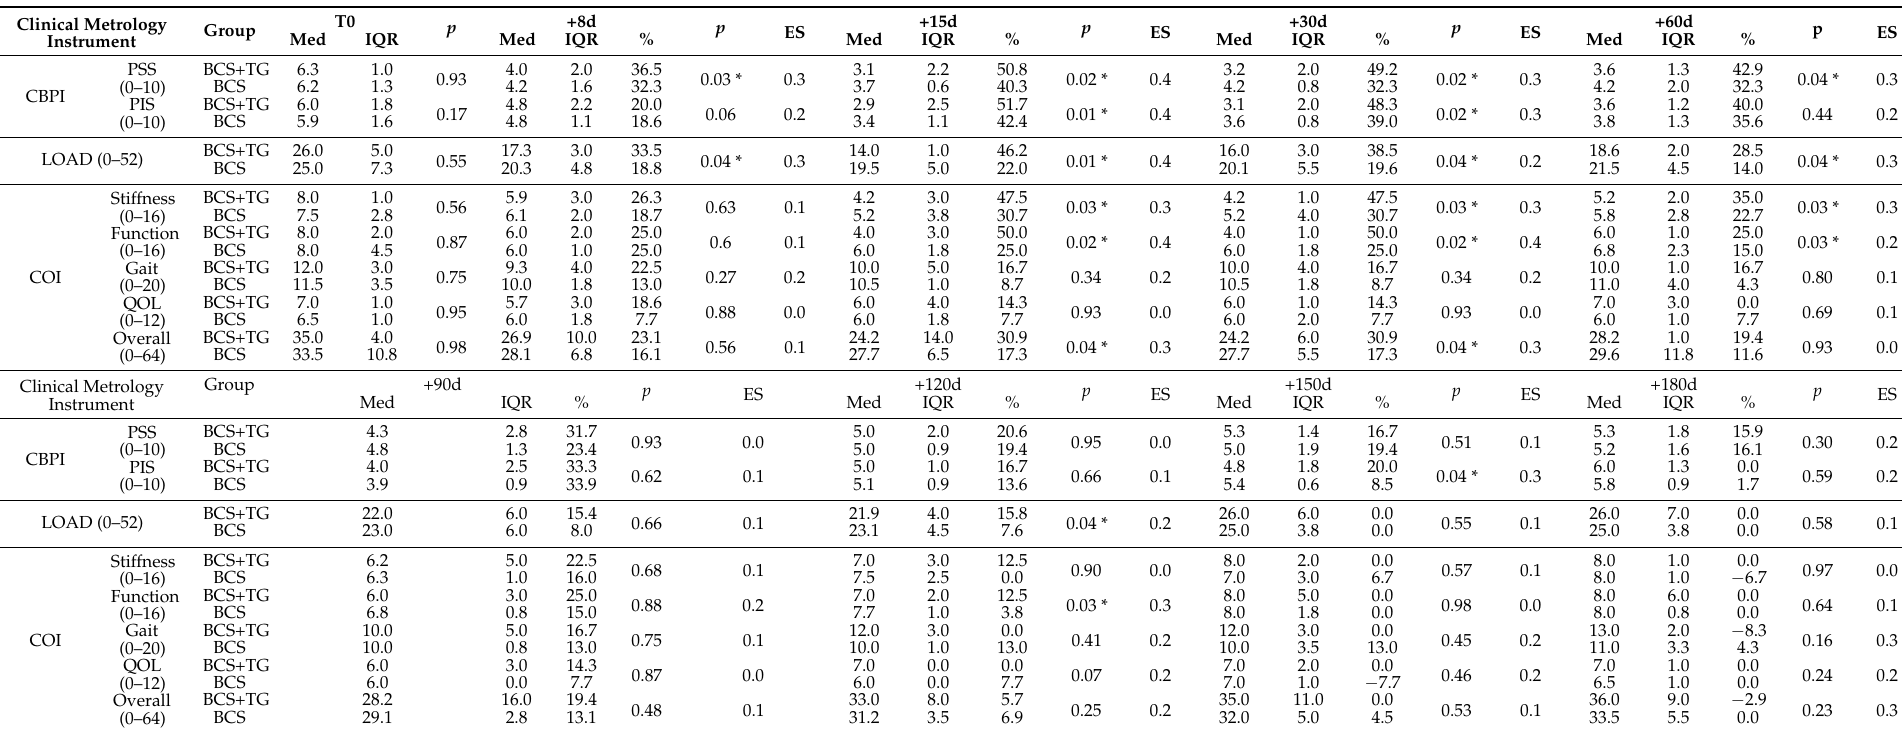
Table 1. Evolution of Clinical Metrology instruments (median score, interquartile range, percentual variation, and effect size), by group, up to the +60 days evaluation moment. CBPI—Canine Brief Pain Inventory; COI—Canine Orthopedic Index; LOAD—Liverpool Osteoarthritis in Dogs; PIS—Pain Interference Score;